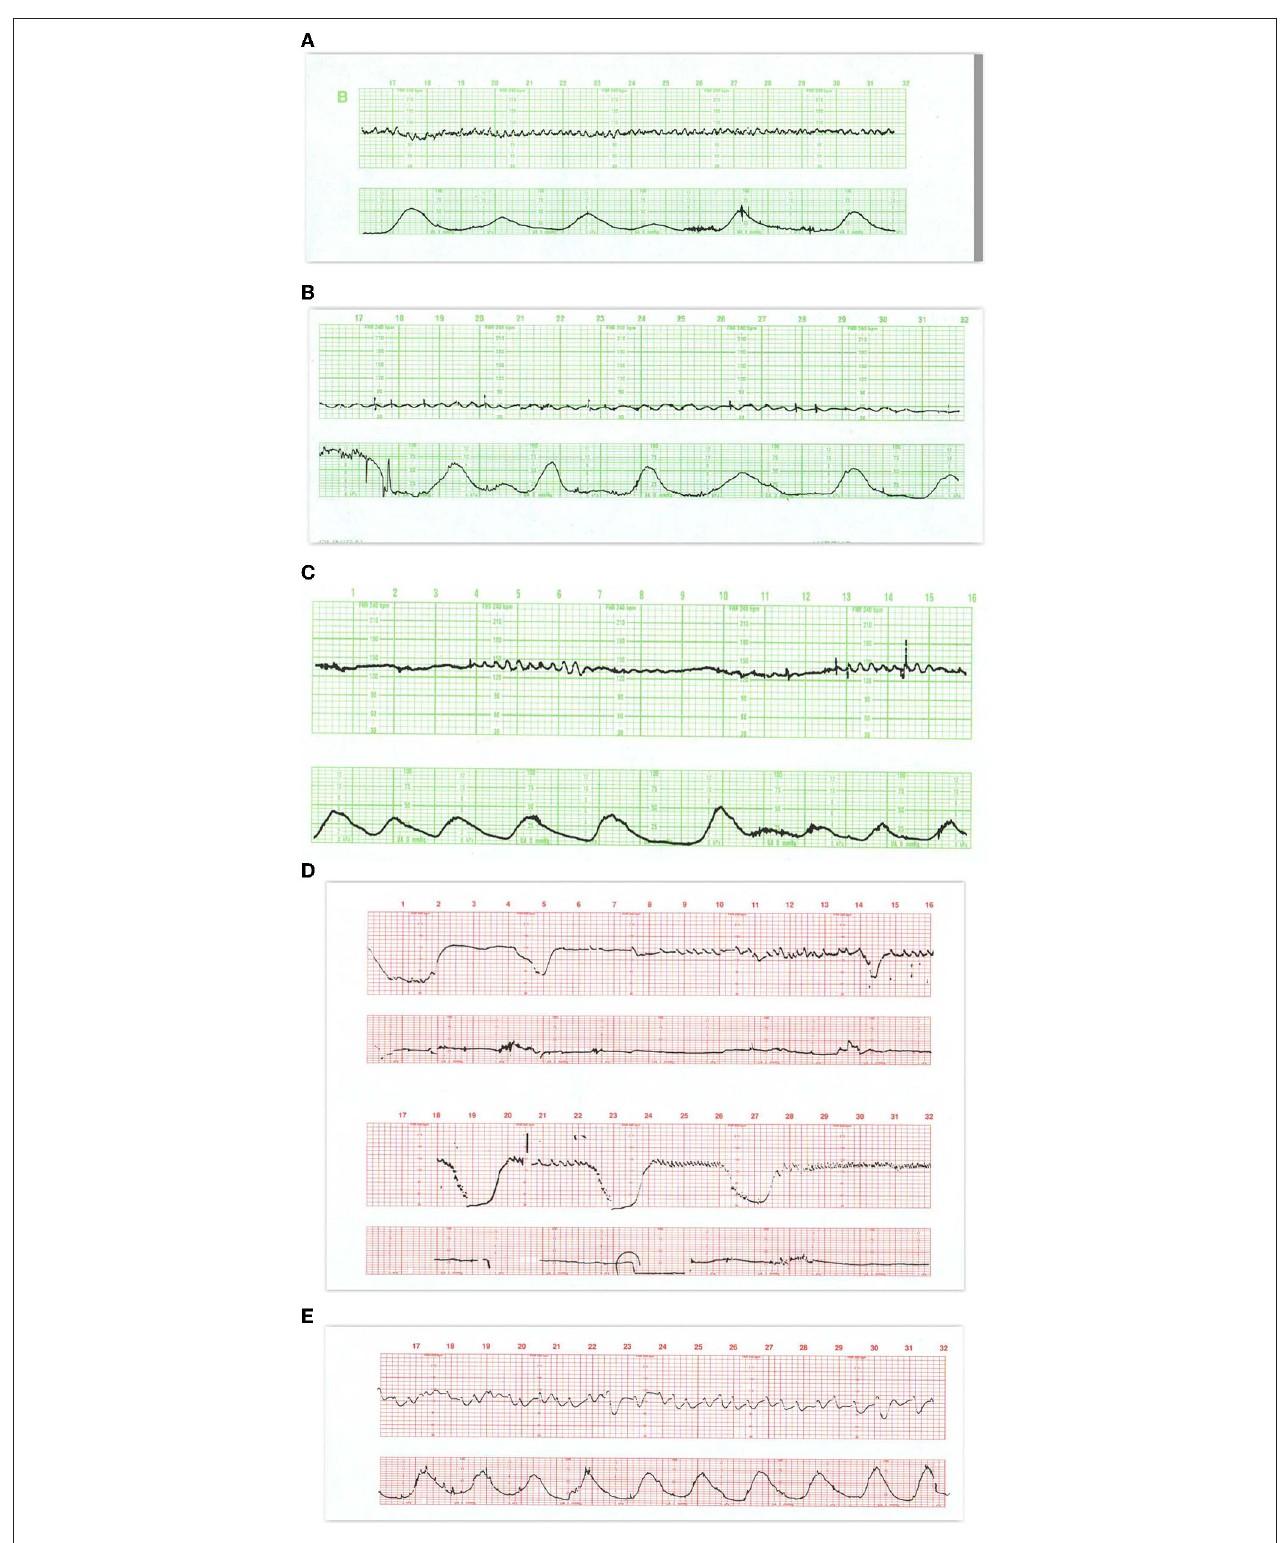
FIGURE 5 | In (A) the appearance of regular oscillations in the baseline invites the designation “sinusoidal pattern.” In this instance, the somewhat, irregular oscillations tend to be peaked and seem to contain short-term variability. Such patterns may be seen with the normal rest-activity cycles in the healthy fetus and referred to